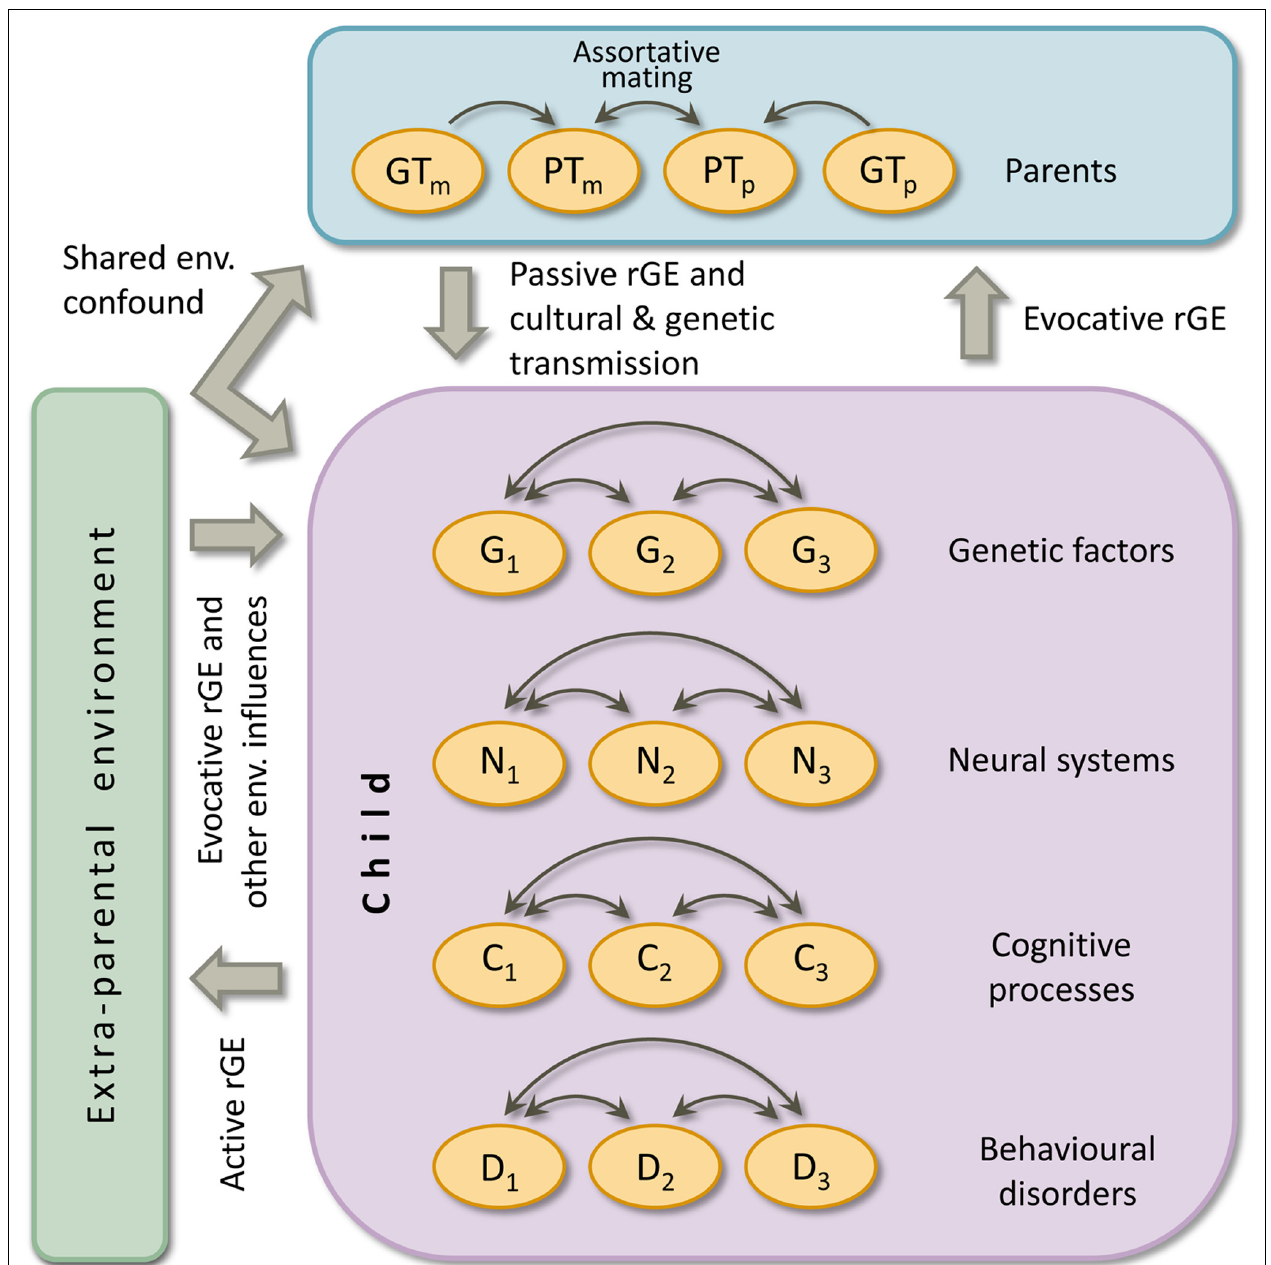
FIGURE 3 |The intergenerational multiple deficit model. Double headed arrows indicate interactions. Causal connections between levels of analyses are omitted. GT m = maternal genotype, PT m = maternal phenotype, GT p = paternal genotype, PT p = paternal phenotype, G = genetic risk or protective factor, N = neural system, C = cognitive process, D = complex behavioural disorder, env. = environmental, rGE =